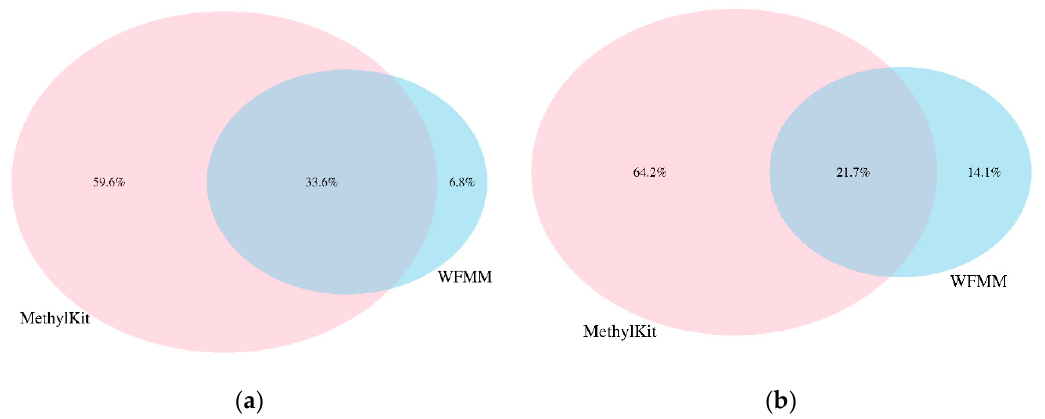
Figure 5. Percentages of overlapping differentially methylated cytosine (DMCs) from methylKit with adjusted settings (difference = 4; q value = 1.00) and WFMM with δ = 0.01 in correlated simulated data